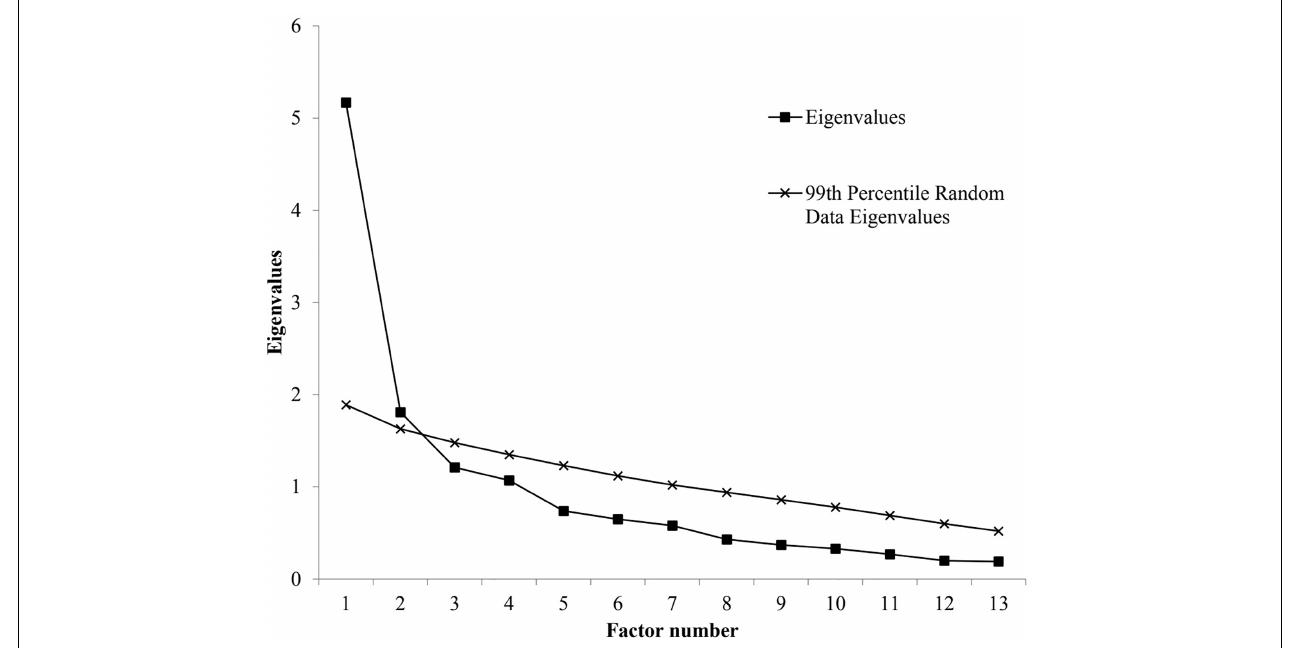
FIGURE 1 | Scree plot and parallel analysis of eigenvalues for the Clinical Assessment Interview for Negative Symptoms (13 items) factors.